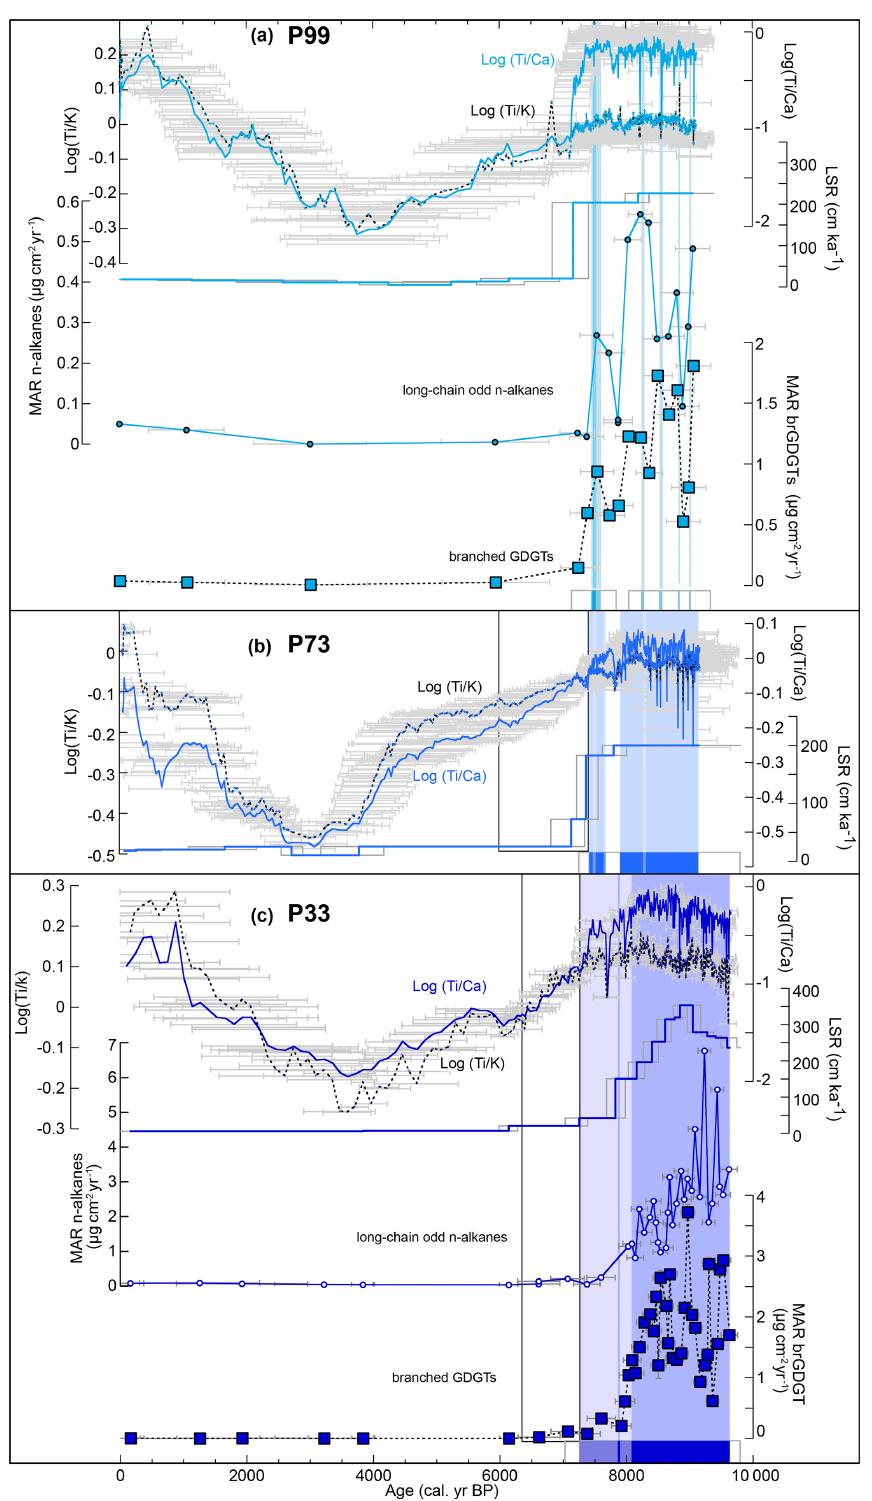
Figure 8. Proxies of terrigenous input in cores (a) P99 (turquoise), (b) P73 (blue) and (c) P33 (dark blue) on an age scale (0–10kaBP). For all cores: Log (Ti / Ca) (continuous lines) and Ti / K (dashed lines), sedimentation rates and lamination pattern (similar colour coding to in Fig. 6). For cores P99 and P33 (a, c) : MAR of odd long-chain n -alkanes (circles and continuous lines) and branched GDGTs (squares and dashed lines). Grey bars show the age